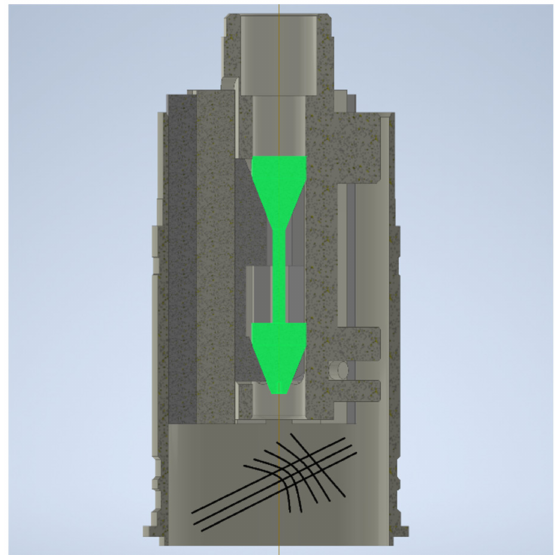
Figure 7. Example of a pattern that is obtained when variable kinematics is